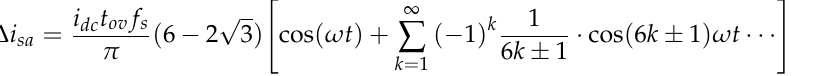
Table 2. Effect of overlap time with the non-nearest three vector. Sector